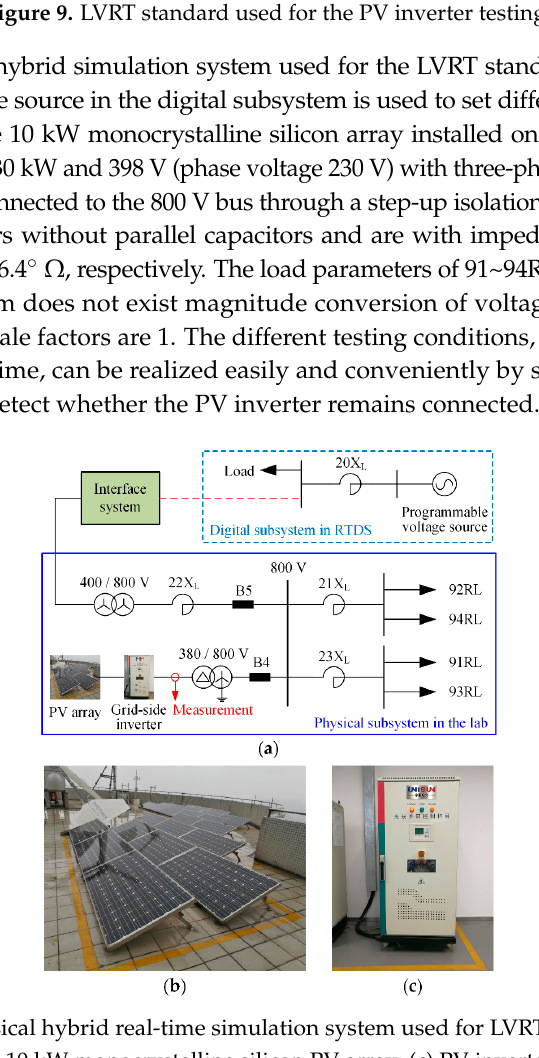
Figure 9. LVRT standard used for the PV inverter testing.